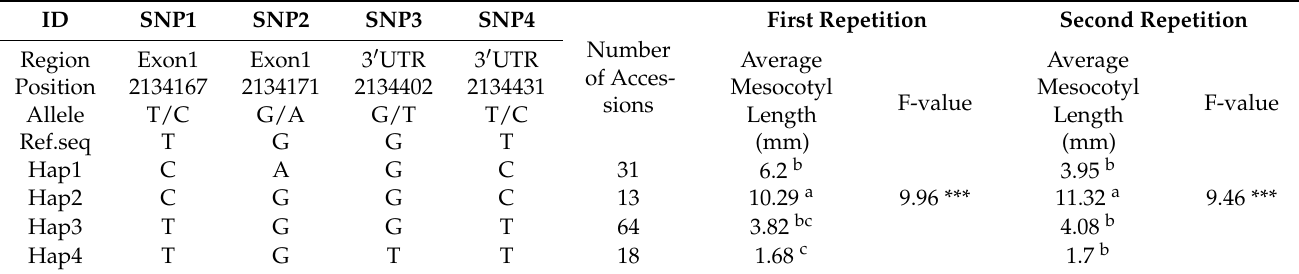
Table 6. Results of haplotype analysis of Os08g0137900